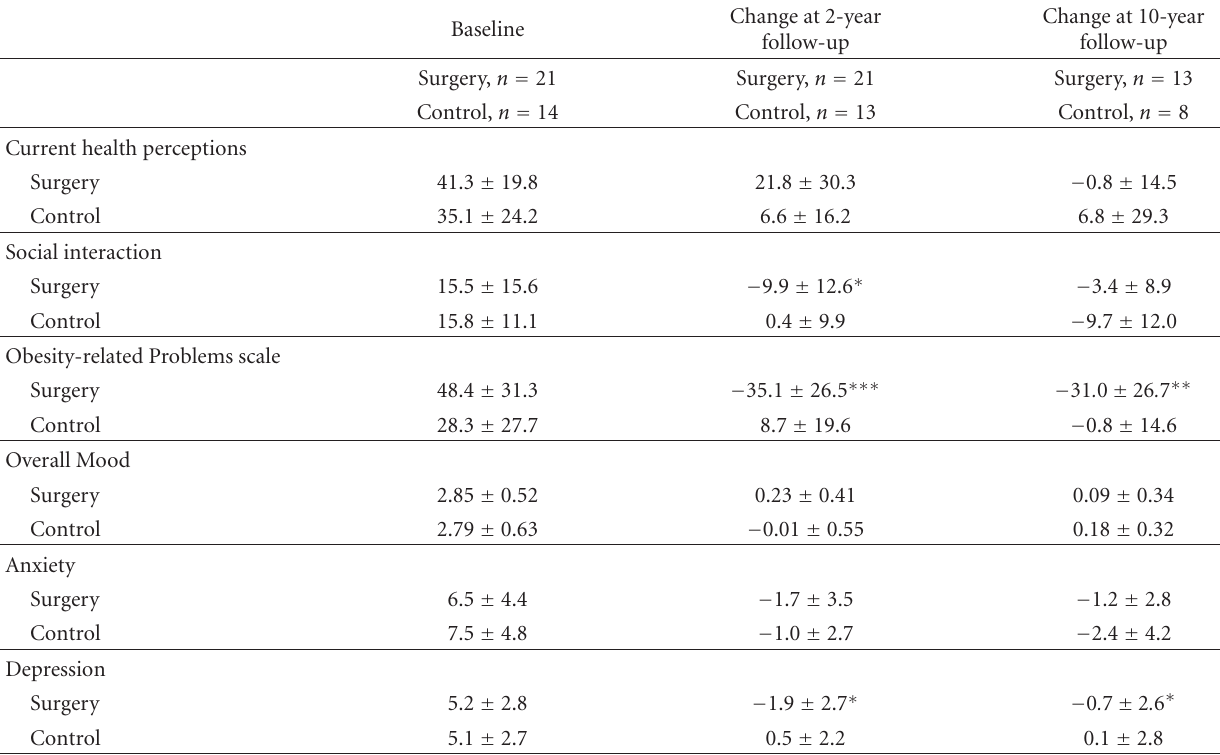
Table 3: Health related quality of life in surgery and control groups at baseline and changes in prevalence after 2 and 10 years of follow-up. Only the patients applicable for the certain timepoint are included in the statistical